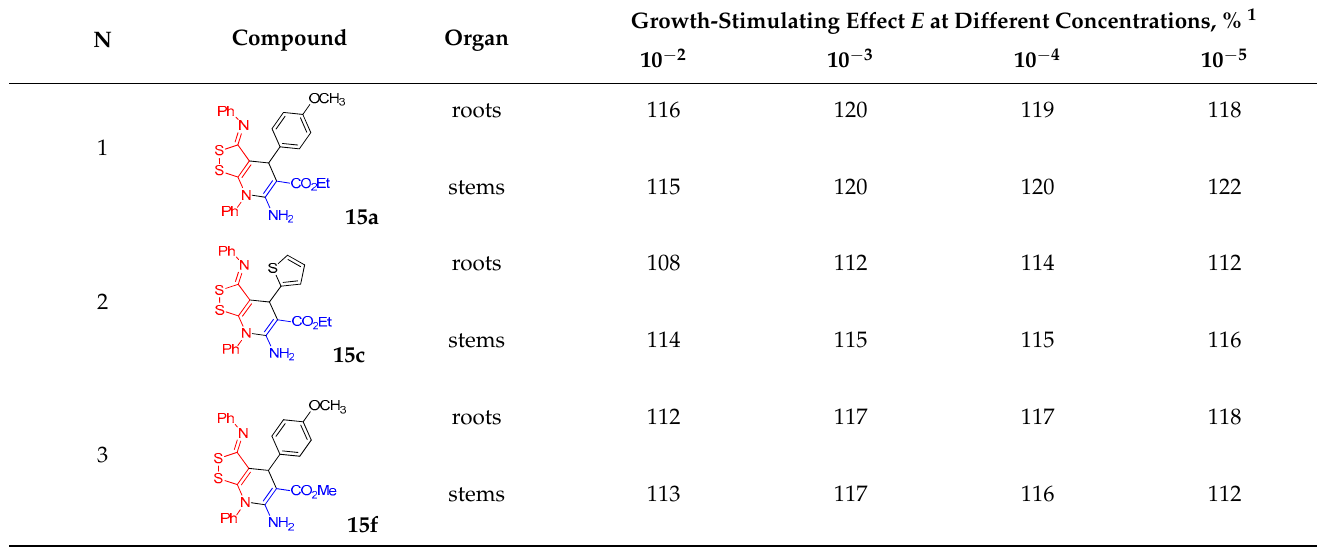
Table 3. The growth-stimulating effects of compounds 15a,c,f . Table 3. The growth ‐ stimulating effects of compounds 15a,c,f . Table 3. The growth ‐ stimulating effects of compounds 15a,c,f . Table 3. The growth ‐ stimulating effects of compounds 15a,c,f